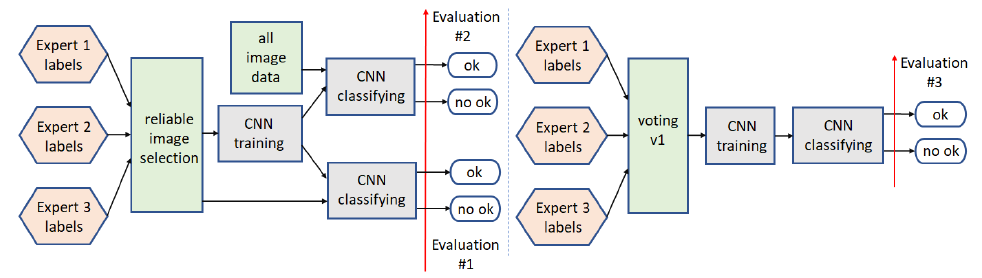
Figure 5. Binary classification schemes: Path1 ( left ) and path2 ( right ).